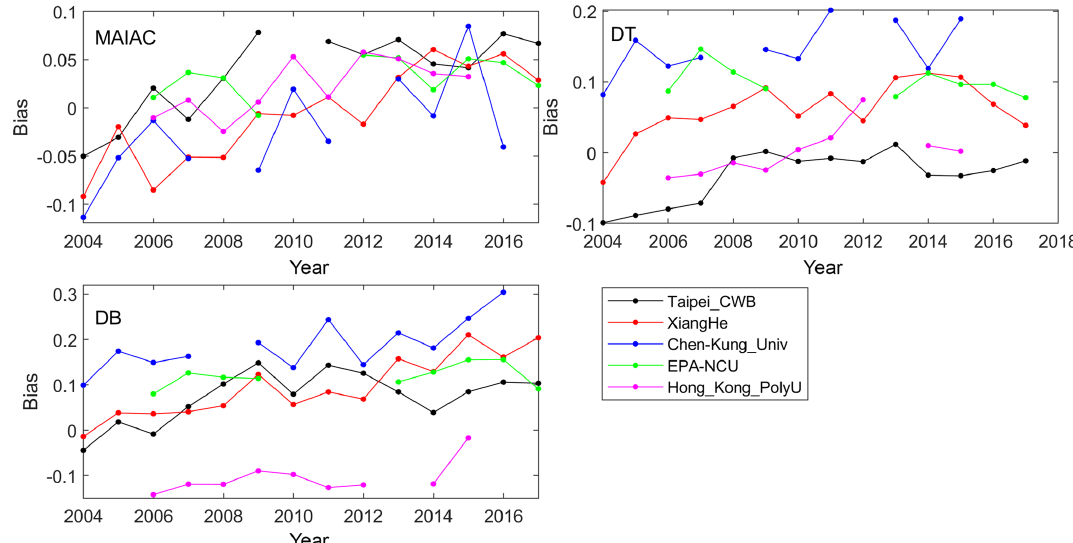
Figure 12. Bias plot for the three products before the QA filter at five selected AERONET sites with a monitoring period containing most of the study years from 2004 to 2017.